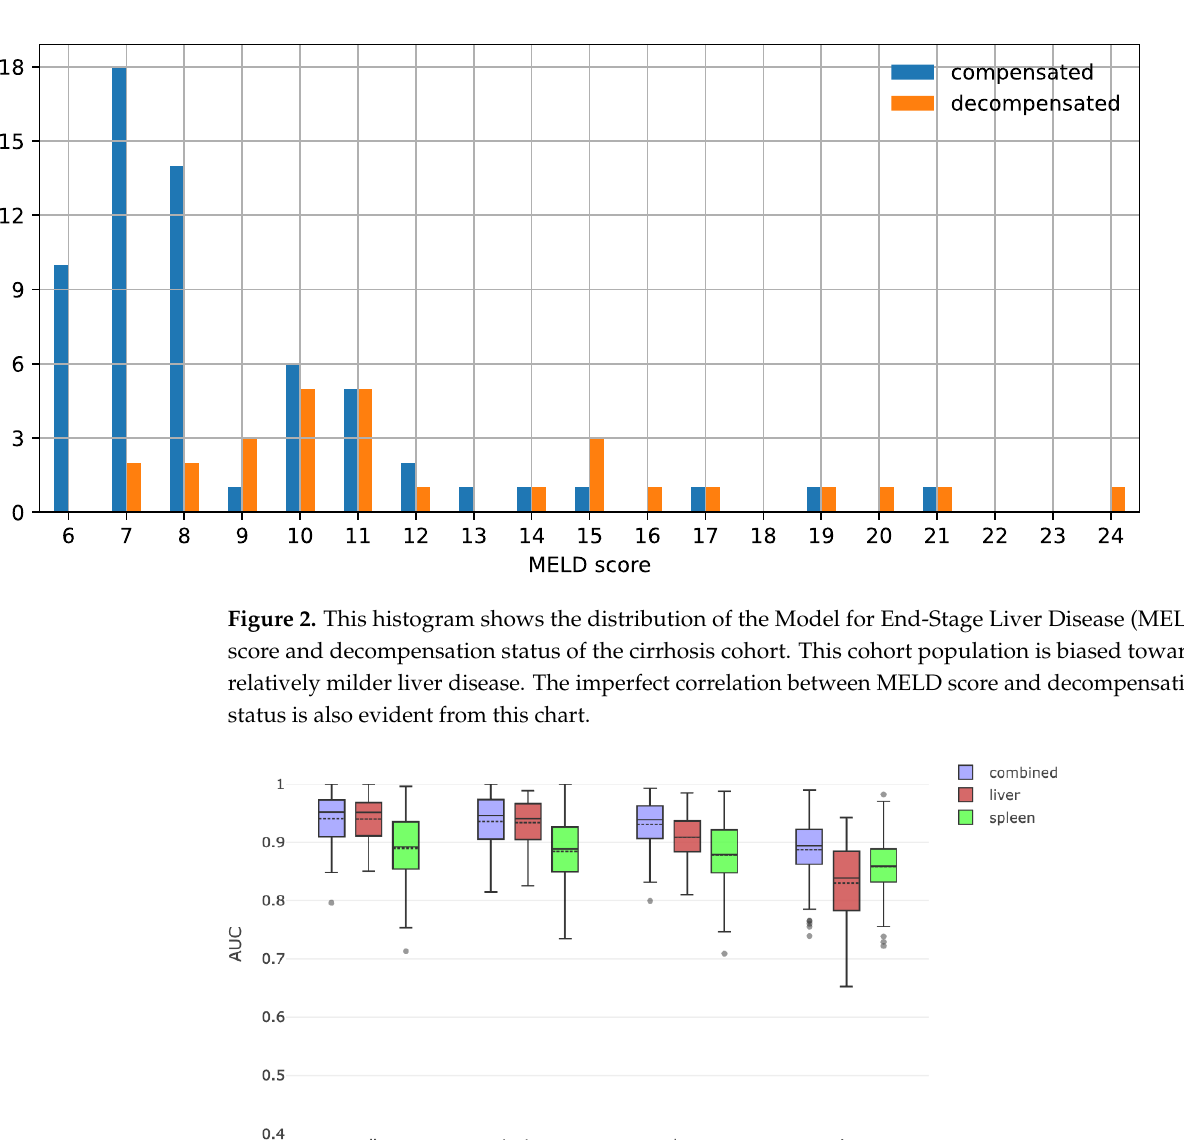
Figure 3. This figure compares the overall radiomic discrimination of cirrhosis between cirrhosis and non-cirrhosis cohorts. Liver features were somewhat more effective in discriminating between the two classes, with texture and shape features being more salient than size features. We then attempted to characterize which of the predefined classes of radiomic fea- tures had the best yield for detecting cirrhosis. We separated features into classes meas- uring shape, texture, and size features. Texture and shape features alone were able to